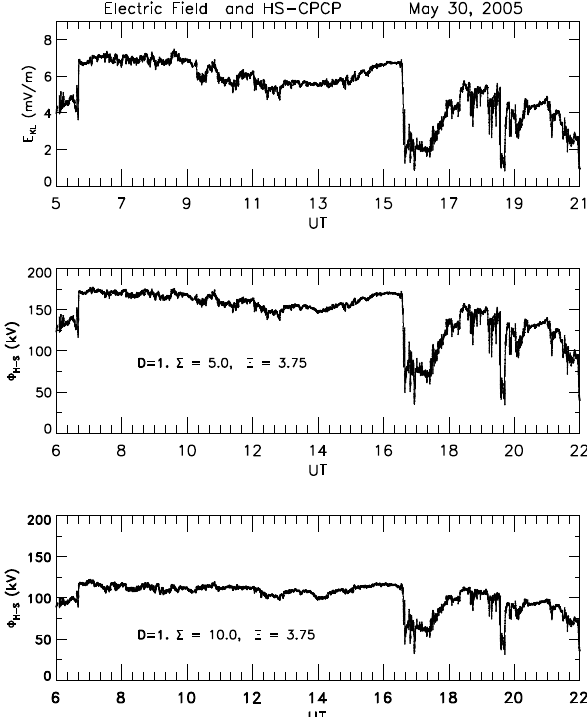
Fig. 11. The geoeffective interplanetary E -field ( E KL ) and Hill- Siscoe CPCPs ( 8 H-S ) during the interval 06:00–22:00UT on 30 May 2005. 8 H-S is taken from Eq. (1) in Hairston et al. (2003). Hill-Siscoe potentials are calculated for the two ionospheric con- ductance values 6 P = 5mho (second panel) and 10mho